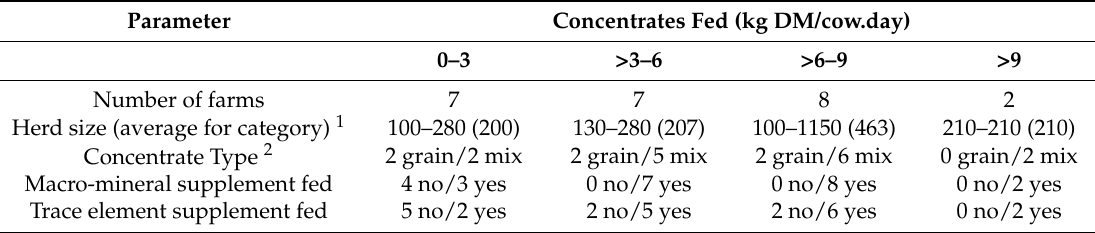
Table 1. Numbers of farms in four categories for amounts of concentrates fed and within those categories for the type of concentrate and whether mineral supplements were